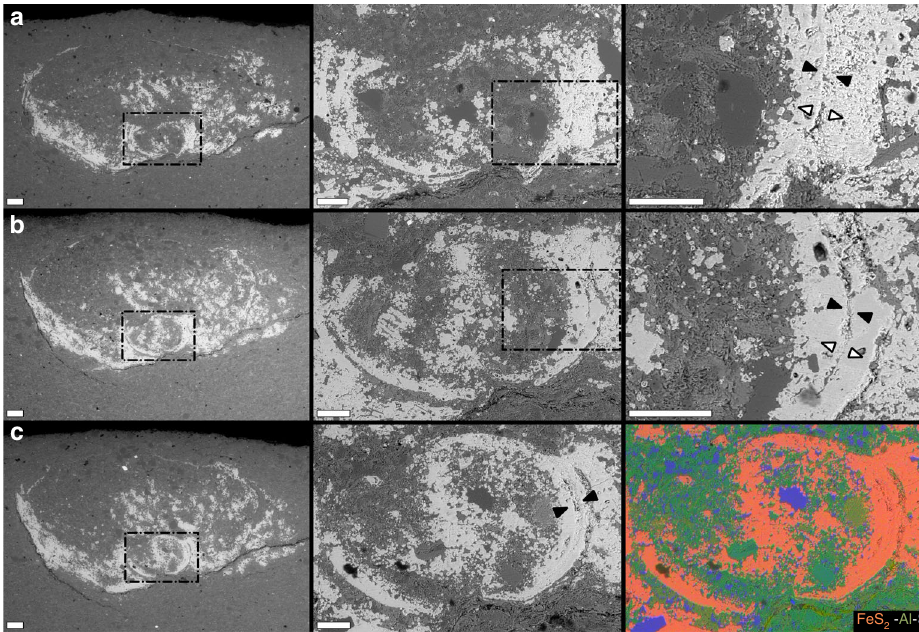
Fig. 6 Additional detail of cross-sectional morphology. SEM backscattered electron micrographs (Z-contrast) of specimen USNM-WCF_001, as shown in Figs. 4, 5. Positioning of slices identi fi ed in Fig. 5f. Each row corresponds to a single slice at increasing magni fi cations from left to right (rows a – c ); dashed boxes in left and middle columns correspond to location for higher magni fi cation images. Right-most frame in row c shows EDS elemental map of middle frame in row c . Soft tissues in these slices are partially pyrite-in fi lled (increasingly so from a to c ), though distinct sediment grains can be observed. Note also distinct soft-tissue wall boundaries, indicated by black arrows in higher magni fi cation views. White arrows in higher magni fi cation views of rows a , b indicate inferred direction of pyrite precipitation from soft-tissue wall, centripetally toward the interior and centrifugally from the exterior. Scales = 200 µ m for left-most column, and 100 µ m for middle and right-most